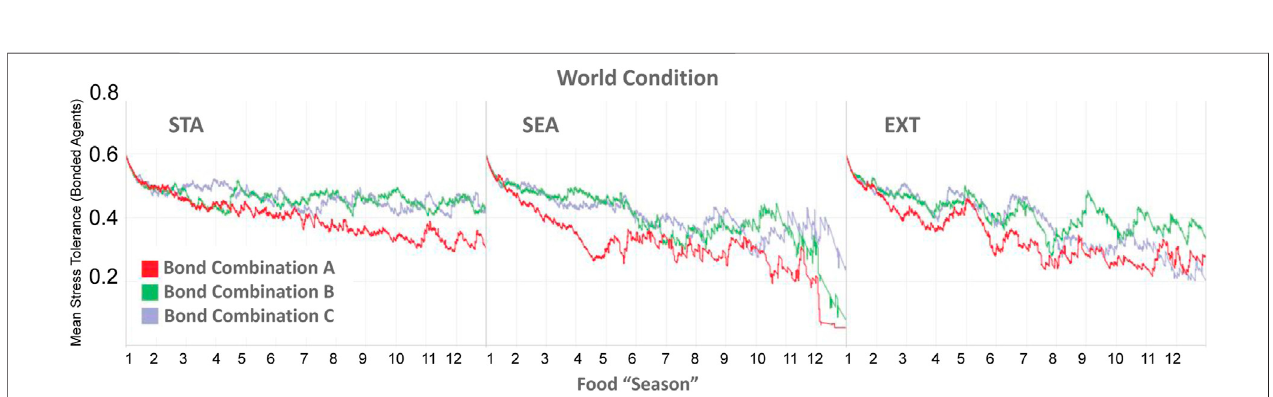
FIGURE 10 | Temporal evolution of the internal Stress Tolerance ( θ ST ) values, aggregated for bonded agents in each bond condition. Bond A = Agents A1, A2, A6 bonded. Bond B A3, A4, A5. Bond C A4, A5, A6. Mean θ ST for individual agents can be seen in Table 5 .